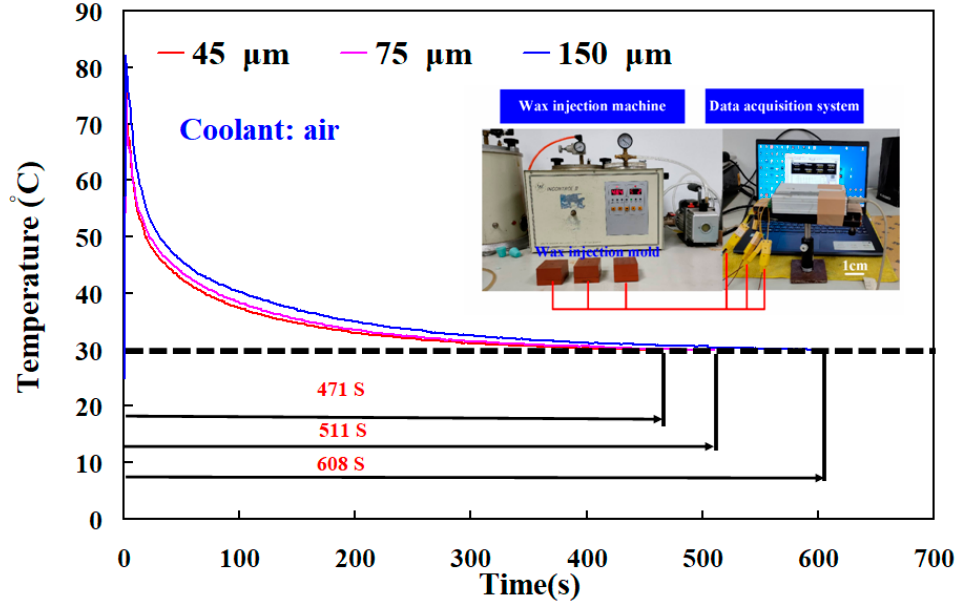
Figure 11. Temperature of wax pattern as a function of the cooling time.